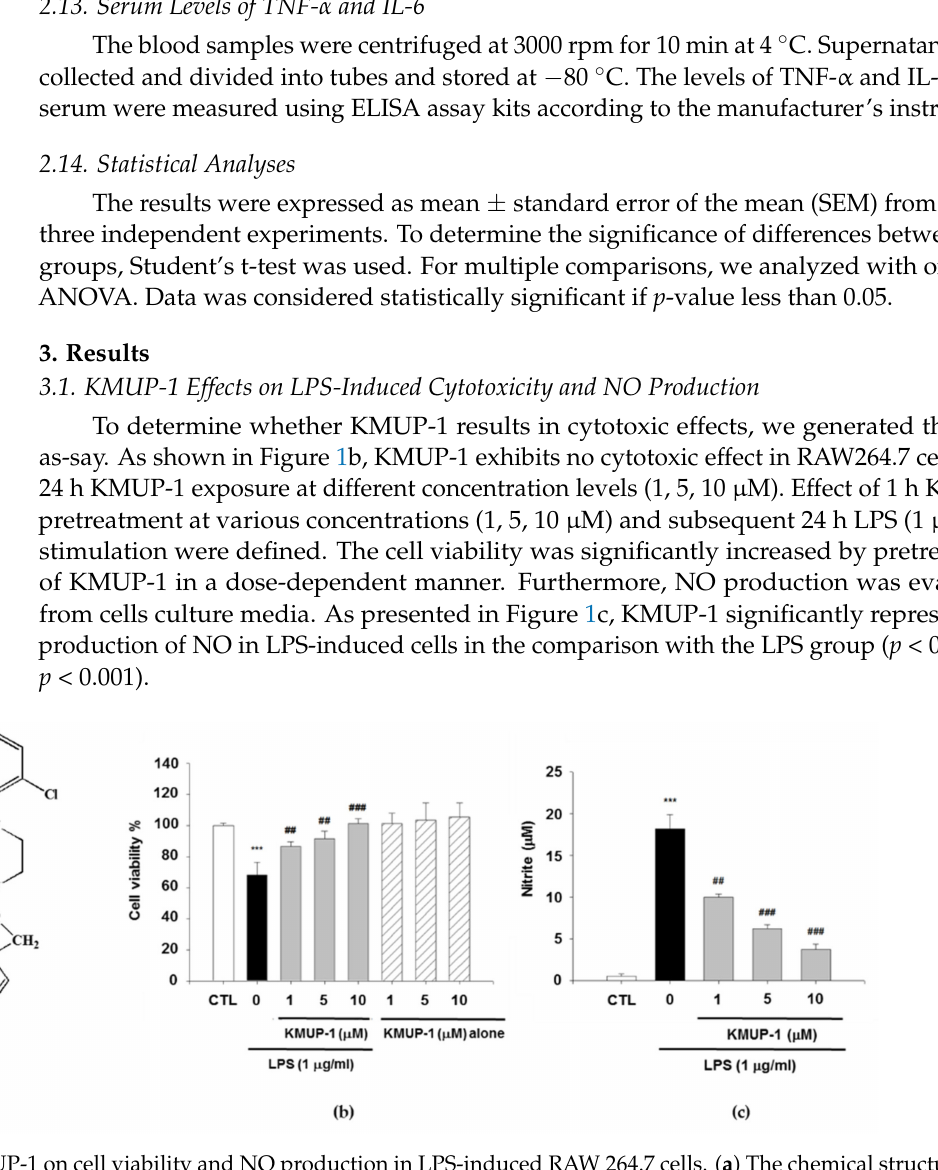
Figure 1. Effects of KMUP-1 on cell viability and NO production in LPS-induced RAW 264.7 cells. ( a ) The chemical structure of KMUP-1. ( b ) The cell viability was determined by MTT assay. ( c ) Griess assay was used to identify nitrite content in the culture media. KMUP-1 treatment was 1 h administered prior to 24 h LPS-induced inflammation exposure. Values are presented as mean ± SEM, n = 6. *** p < 0.001 compared to control group (CTL). ## p < 0.01 and ### p < 0.001 compared to LPS